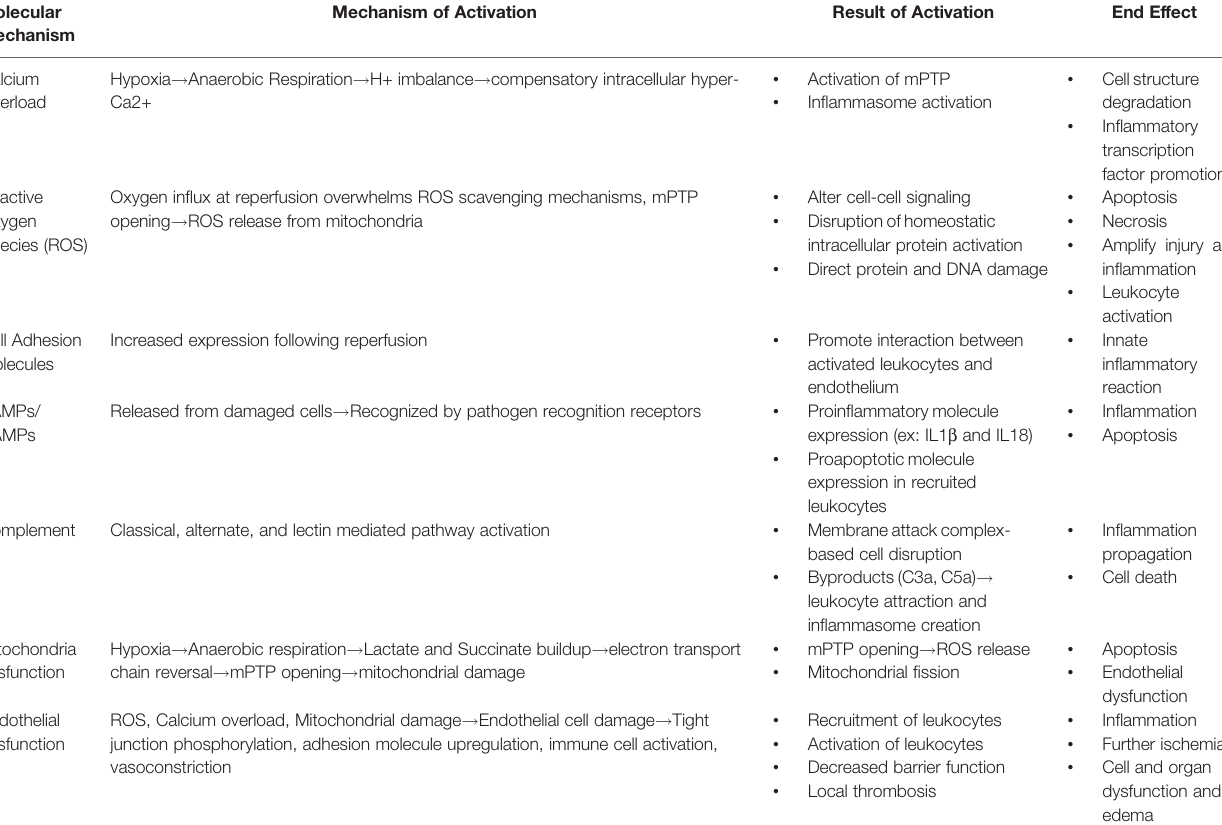
TABLE 1 | Enumeration of the various molecular mechanisms at play during ischemia reperfusion injury, their various mechanisms of activation, how their activation propagates injury, and the end effect of the activation. Molecular Mechanism of Activation Result of Mechanism